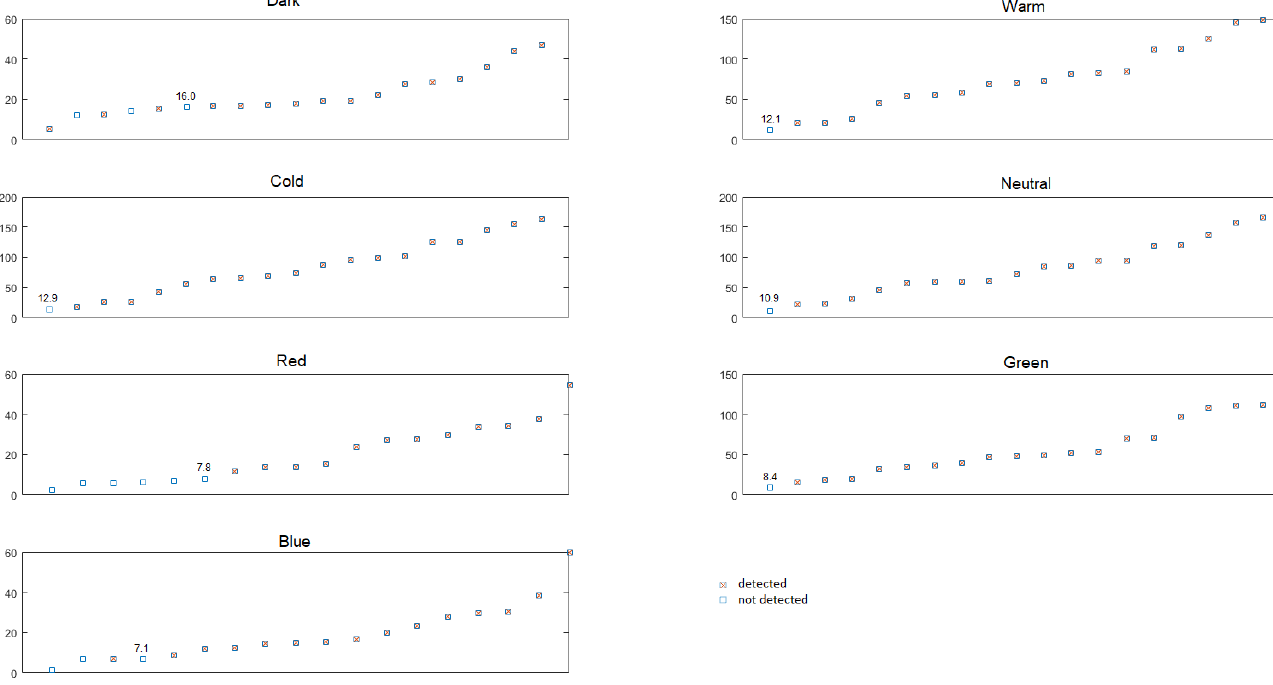
Figure 15. Analysis of the F-points’ detection ability, depending on the MeanG feature, divided bystudy type. Figure 16. The value of the correlation coefficient between XYZ total error and the F-point features.